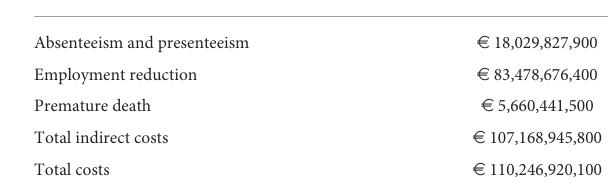
TABLE 7 Costs with presenteeism and absenteeism ( e ), by disease, age group, and sex.